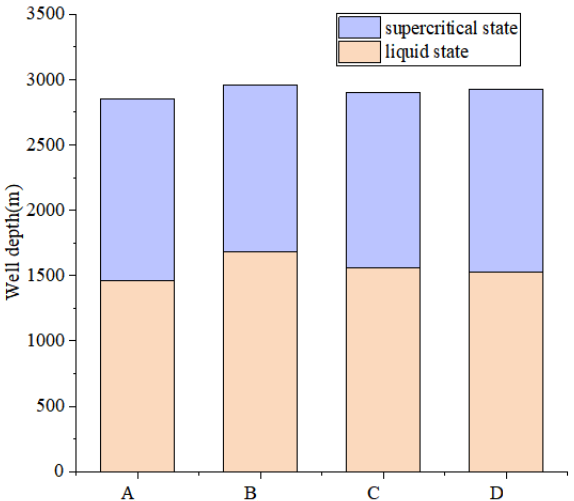
Figure 6. Phase distribution diagram of CO 2 fluid in four port injection strings. Under complex field conditions, CO 2 injection strings will elongate and contract.